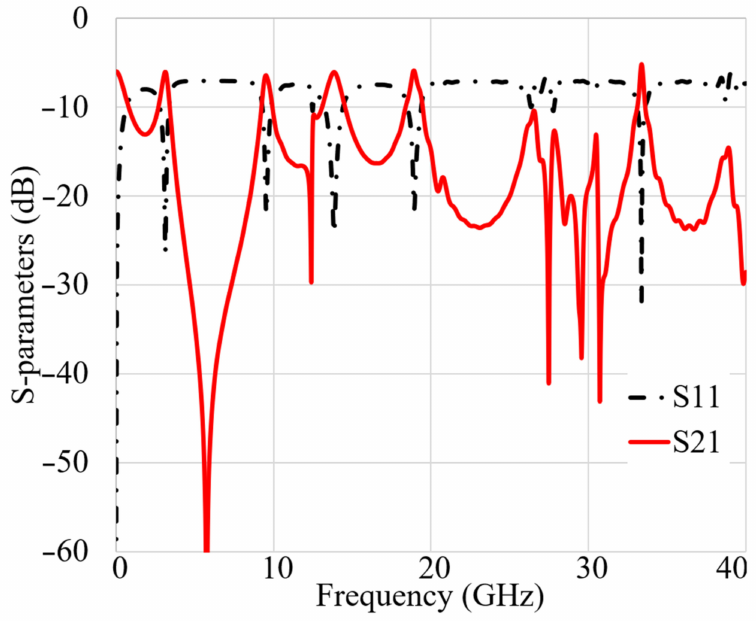
Figure 11. MTM unit cell structure